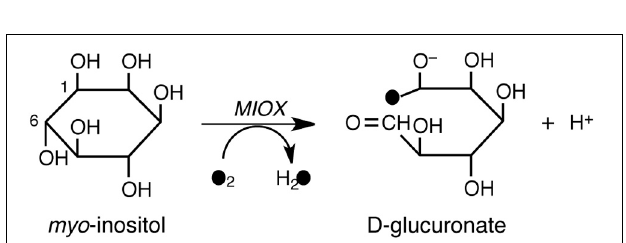
SCHEME 7 | MIOX-catalyzed conversion of myo -inositol into D-glucuronate. Reprinted from Hirao and Morokuma (2009) with permission from the American Chemical